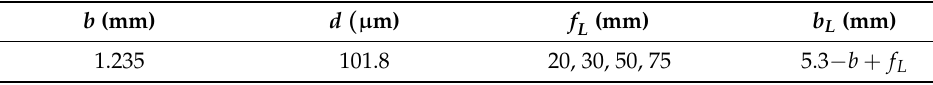
Table 2. Intrinsic parameters for vari-focal light field camera.